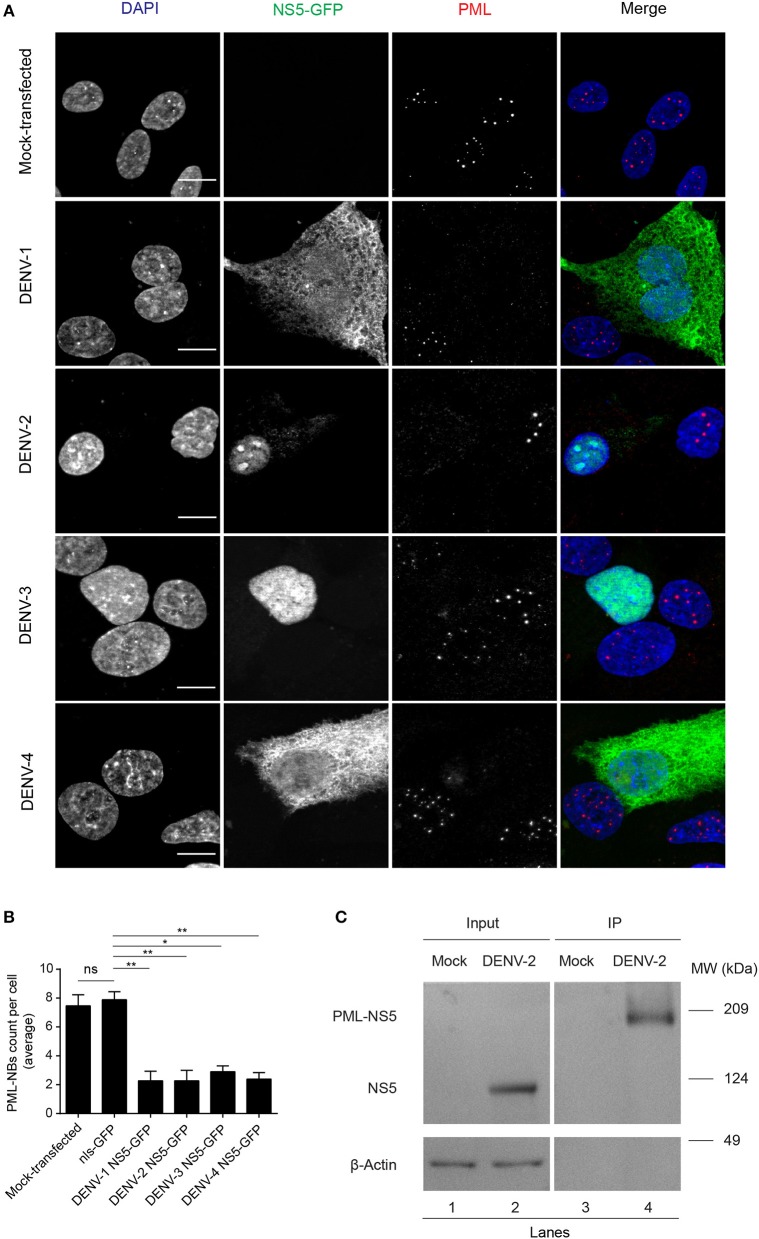
NS5 from DENV1-4 is sufficient to mediate PML-NBs disassembly. (A) A549 cells were transfected with plasmids encoding for NS5-GFP of DENV1-4 (green). 24 h later, cells were fixed and stained for PML (red). Images of optical sections were acquired using a Zeiss Apotome.2 setup. Scale Bar: 10 μm. (B) Quantification of the average number of PML-NBs per nucleus was as per the legend to Figure 2B. ns, not statistically significant; *p < 0.05; **p < 0.01 (one-way ANOVA followed by Tukey's post-hoc test). (C) A549 cells were mock-infected or infected with DENV-2 and 48 h p.i. they were harvested for immunoprecipitation against PML followed by Western blot against DENV-2 NS5. Lanes 1 and 2 correspond to whole cell lysates (Input) and 3 and 4 correspond to precipitates (IP). Images are representative of three independent experiments.